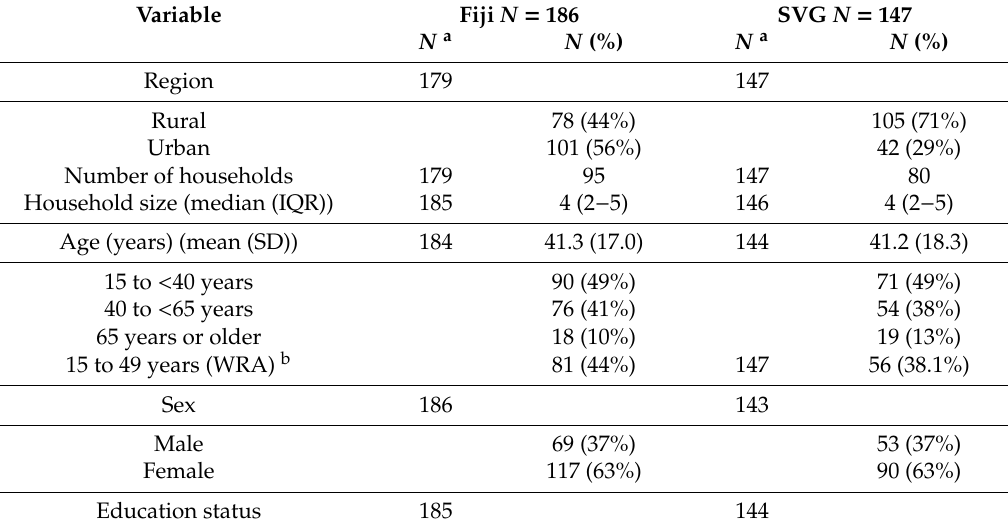
Table 2. Characteristics of the CFaH project study populations in Fiji and